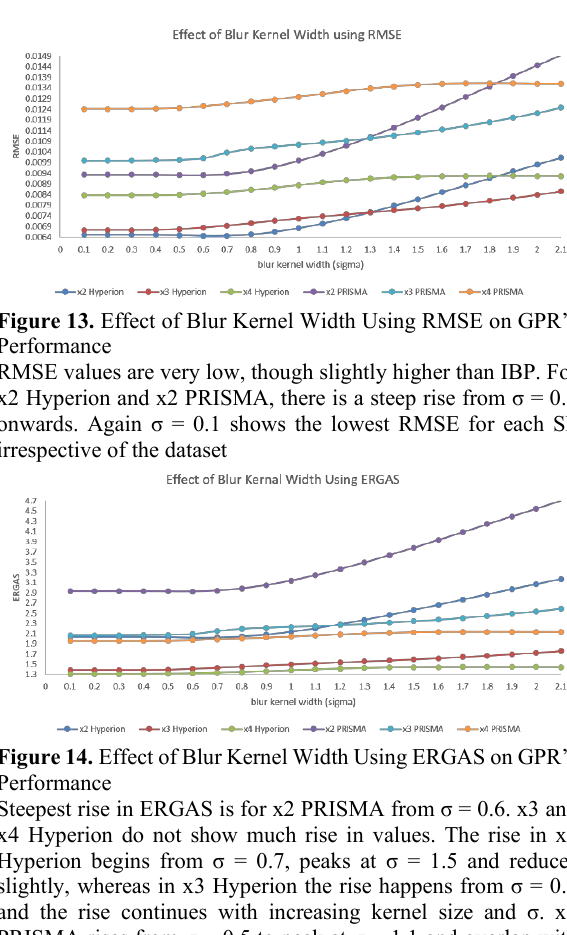
Figure 11. Effect of Blur Kernel Width Using RASE on GPR’s Performance